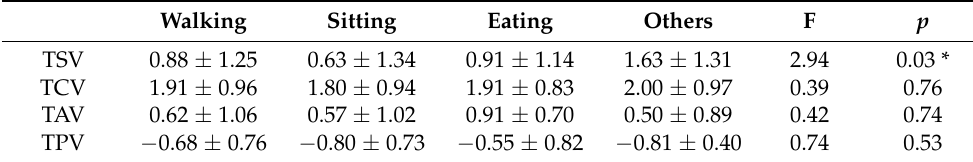
Table 12. Difference analysis of short-term activity and weather perception. Walking Sitting Eating Others F p